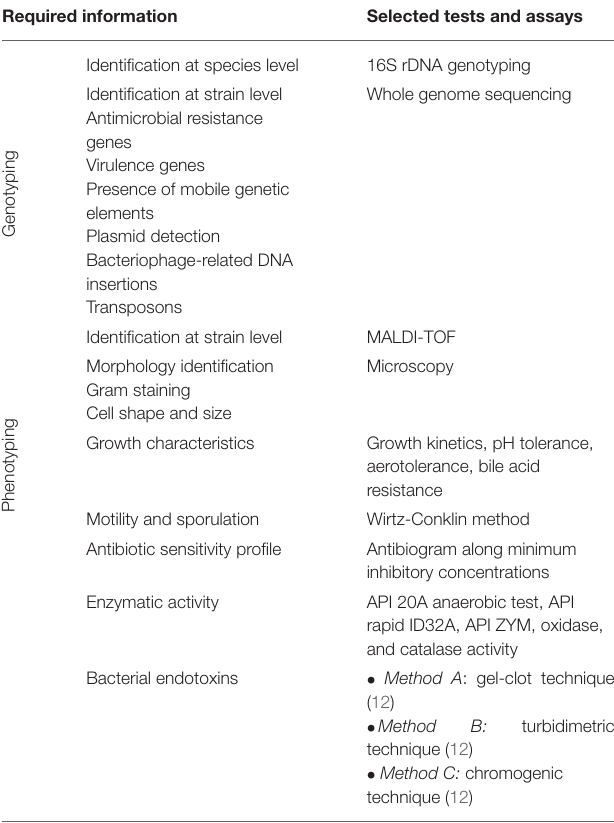
TABLE 2 | Quality requirements from both EU and US regulatory authorities for strain characterization. Required